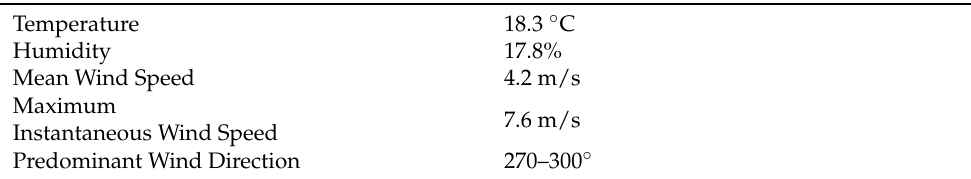
Table 1. Weather observations during the 16 min of thermal imagery collection. Readings were taken in a clear field unaffected by tree cover approximately 500 m upwind of the